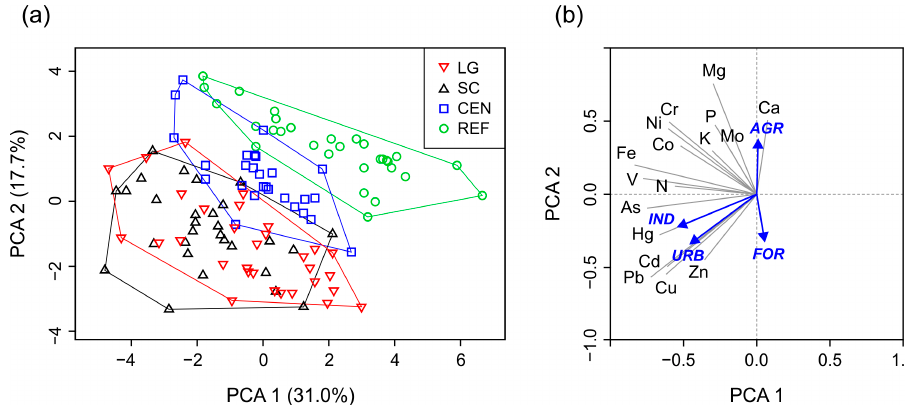
Figure 5. The results of principal component analysis (PCA) on the concentration of 17 elements in moss sampled at 117 sites in Poland. The PCA axes explain jointly 48.7% of the total variation in the data. For clarity, the sampling sites (marked according to the surveyed region; see the text for explanation) and elements are shown in separate diagrams, ( a ) and ( b ), respectively. In the right diagram, four land cover categories (URB—urban area, IND—industrial area, AGR—agricultural area, FOR—forest area) are passively projected in the ordination space. Table 2. Factor loadings (varimax-rotated) of element concentrations in moss determined by a factor analysis for 117 sampling sites in 2015. Loadings greater than 0.5 are in bold.